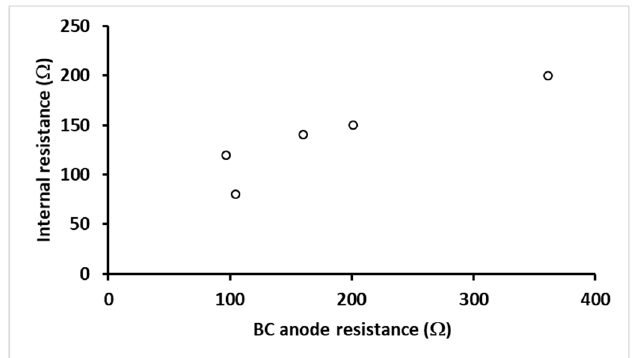
Figure 7. Internal resistance vs. bamboo charcoal anode resistance.